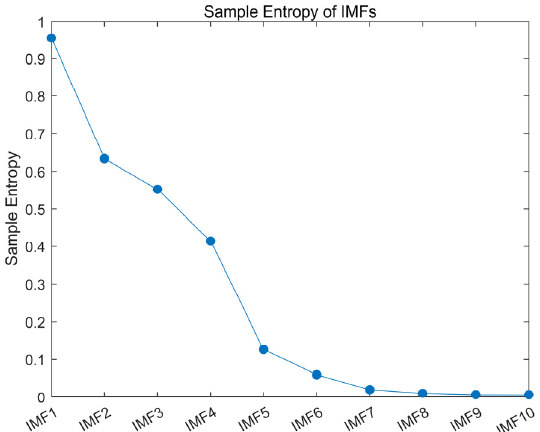
Figure 4. Sample Entropy of IMFs.